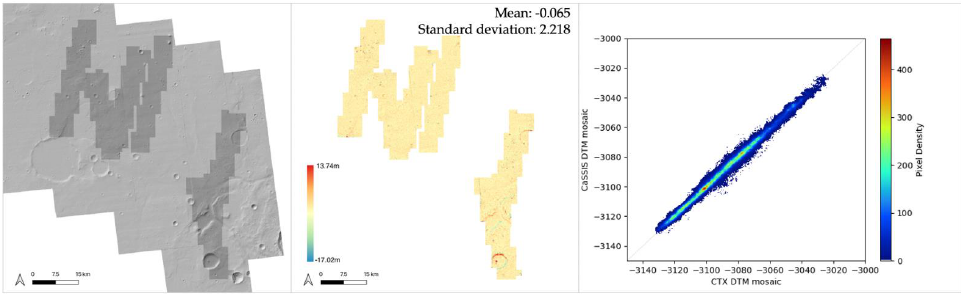
Figure 9. Hill-shaded image of the CaSSIS DTM mosaic superimposed on the hill-shaded image of the CTX DTM mosaic ( left ); difference map of between the CaSSIS and CTX DTM mosaics ( middle ); scatter plots of the CaSSIS and CTX DTM mosaics ( right ).